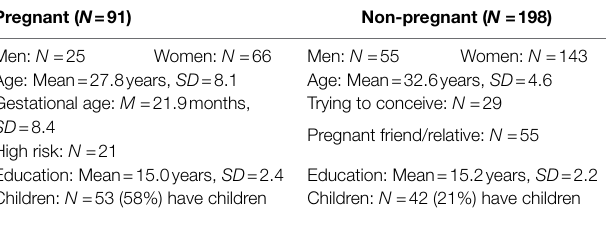
TABLE 1 | Distributions of demographic